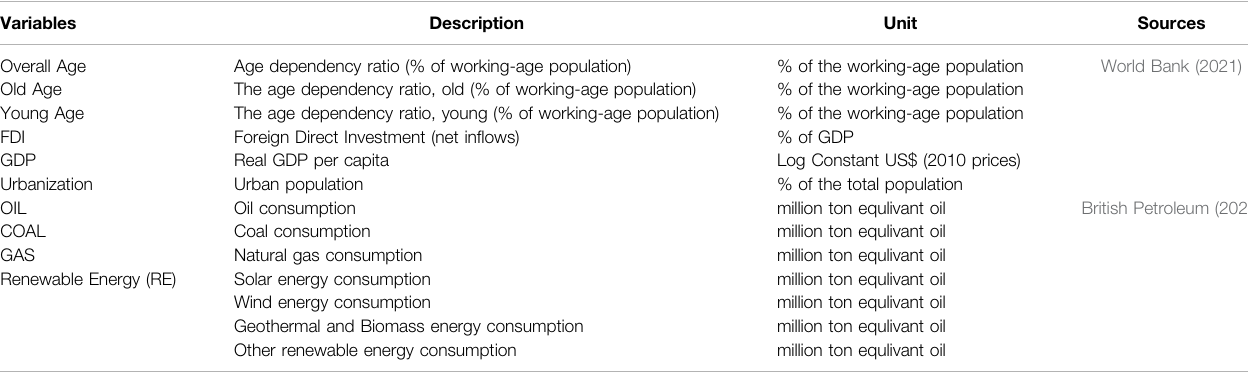
TABLE 2 | Variables used in the study.